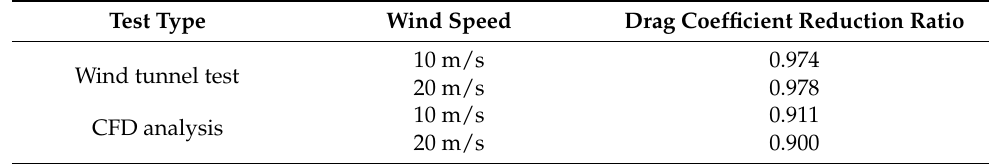
Table 4. Drag coefficient reduction ratio of perforated road